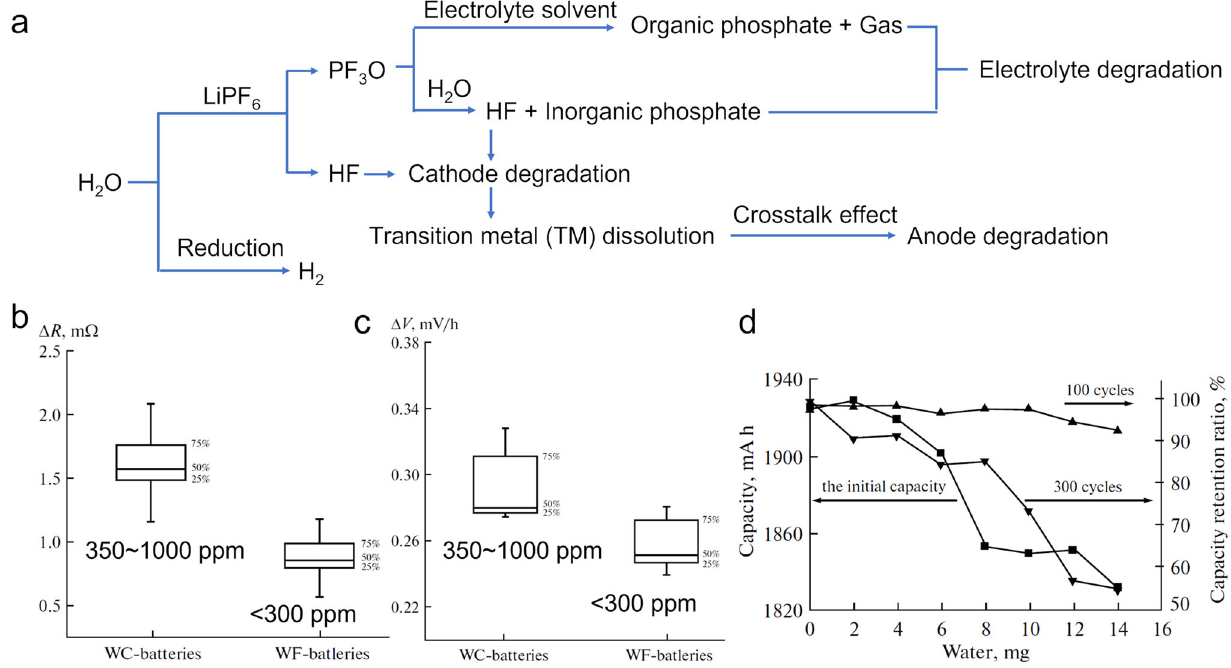
Fig. 1 Effects of water content on electrolytes. a Schematic summary of the effects of water in electrolytes. b The internal resistance variation ( Δ R ) of LIBs before and after charging for water-containing (WC) batteries and water-free (WF) batteries. c The voltage variation ( Δ V ) of LIBs for WC batteries and WF batteries after 168 h aging at a high voltage of 4.2 V. d The initial capacities and cycling behaviors (100 cycles and 300 cycles, 0.5 C charging/0.5 C discharging) of batteries contained different water dosages. Reproduced with permission from reference 17 , copyright (Springer Nature,